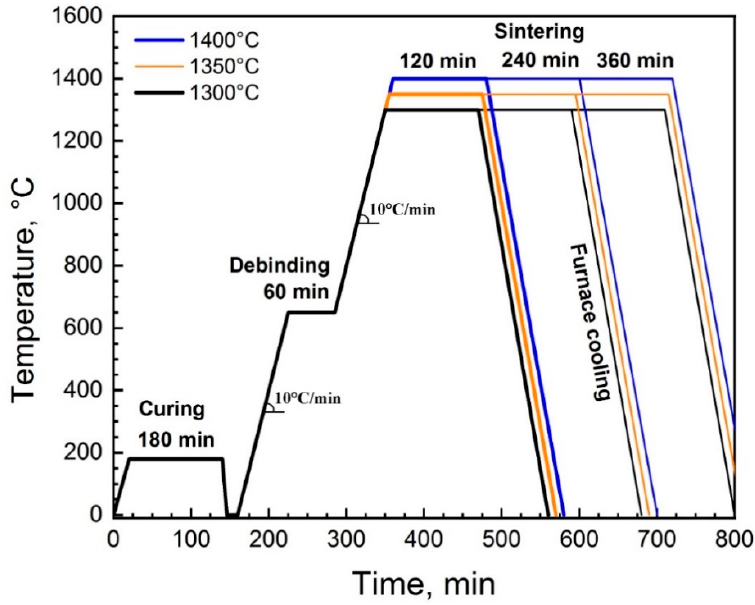
Figure 5. The thermal post-treatment profile.